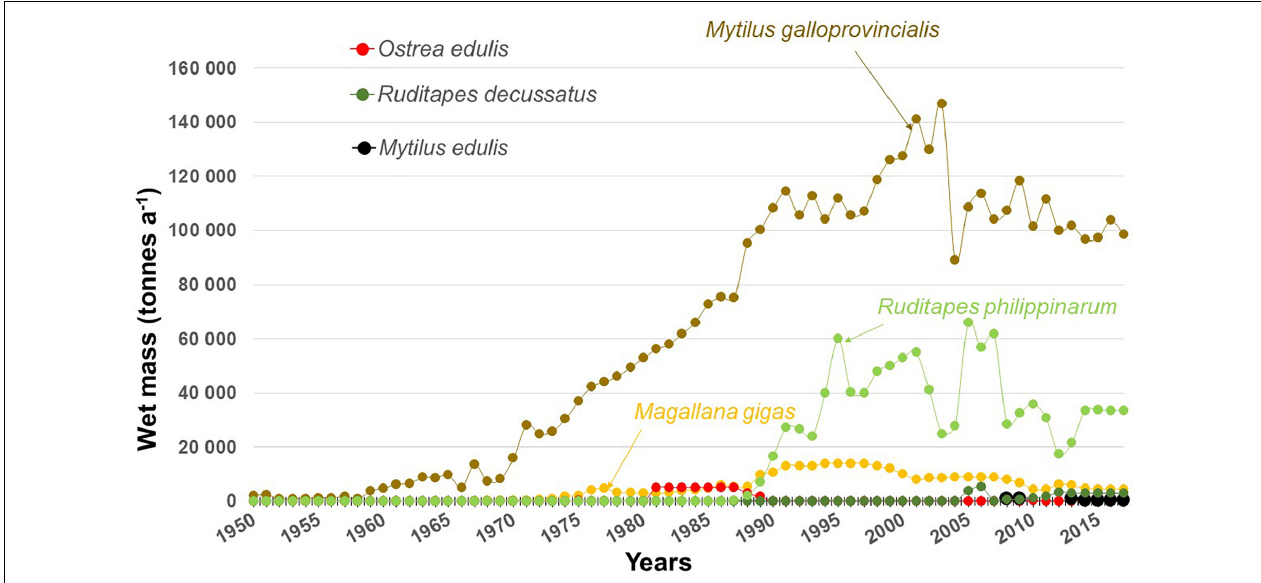
FIGURE 3 | Shellfish production in the Mediterranean. For the countries which have both Atlantic and Mediterranean shores (France and Spain), Atlantic production has been removed from the statistics. Data from FAO (2019).